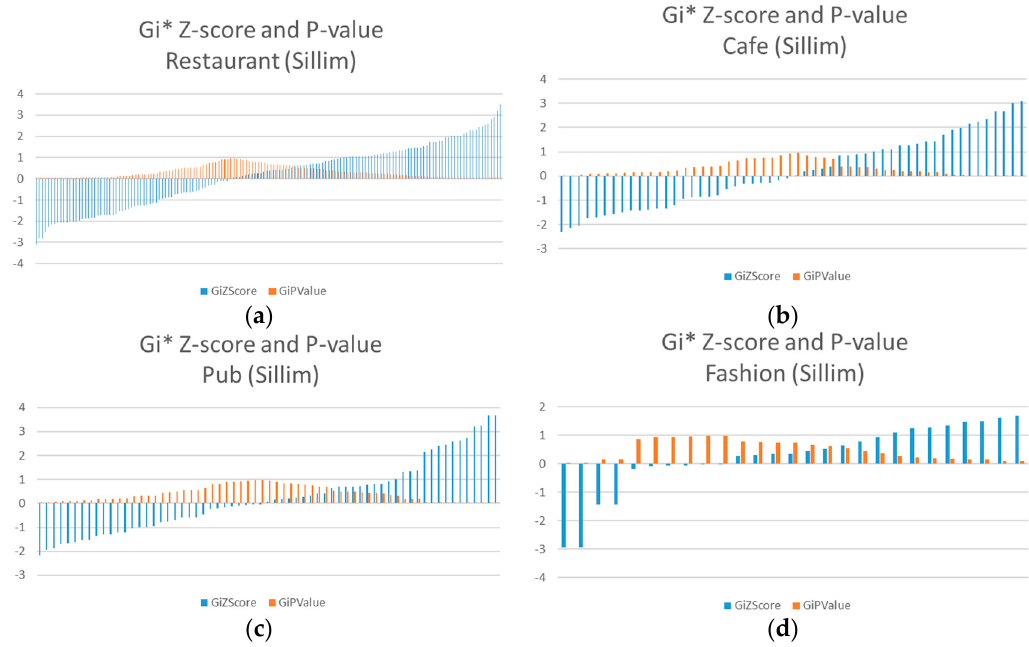
Figure 10. (cid:1833) (cid:3036)∗ z-scores and p-values of the road segments of each theme in the Sillim test area: ( a ) restaurant; ( b ) café; ( c ) fashion; ( d ) pub.